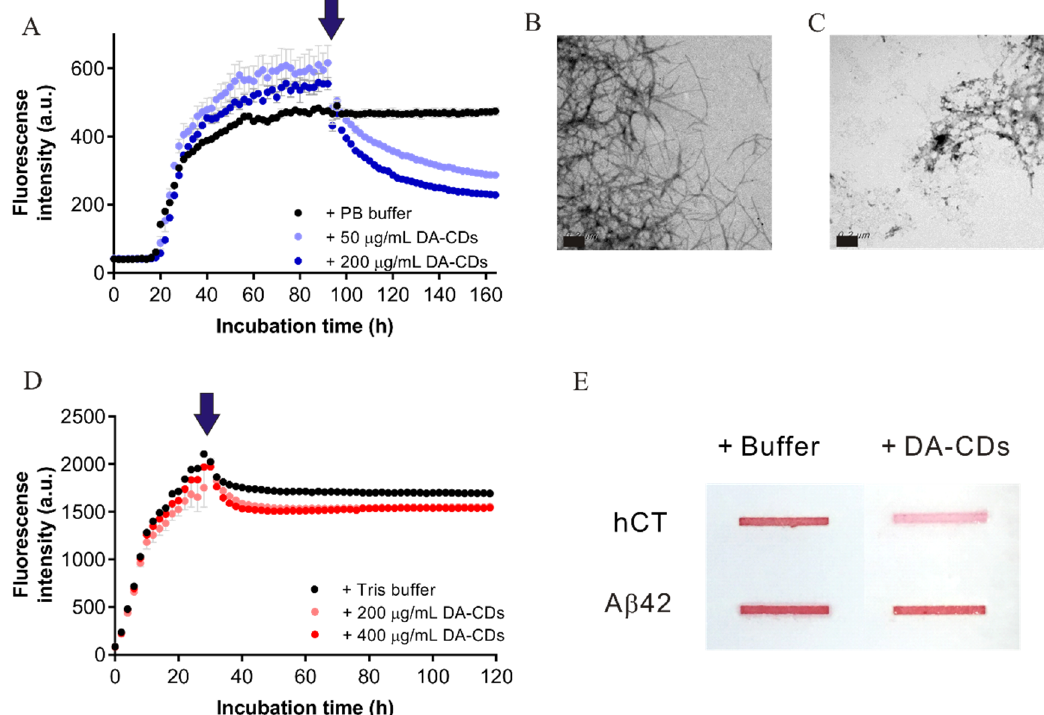
Figure 6. The dissociating capability of DA-CDs toward different amyloidogenic proteins. ( A ) ThT-monitored hCT fibril dissociation by DA-CDs. ( B ) TEM images for ThT end products with an addition of buffer as a control study. ( C ) TEM images for ThT end products with the addition of 200 µ g/mL DA-CDs at reaction plateau. Scale bar represents 200 nm. ( D ) ThT-monitored A β fibril dissociation by DA-CDs. ( E ) Slot blotting for remaining large aggregates stained by Ponceau- S.